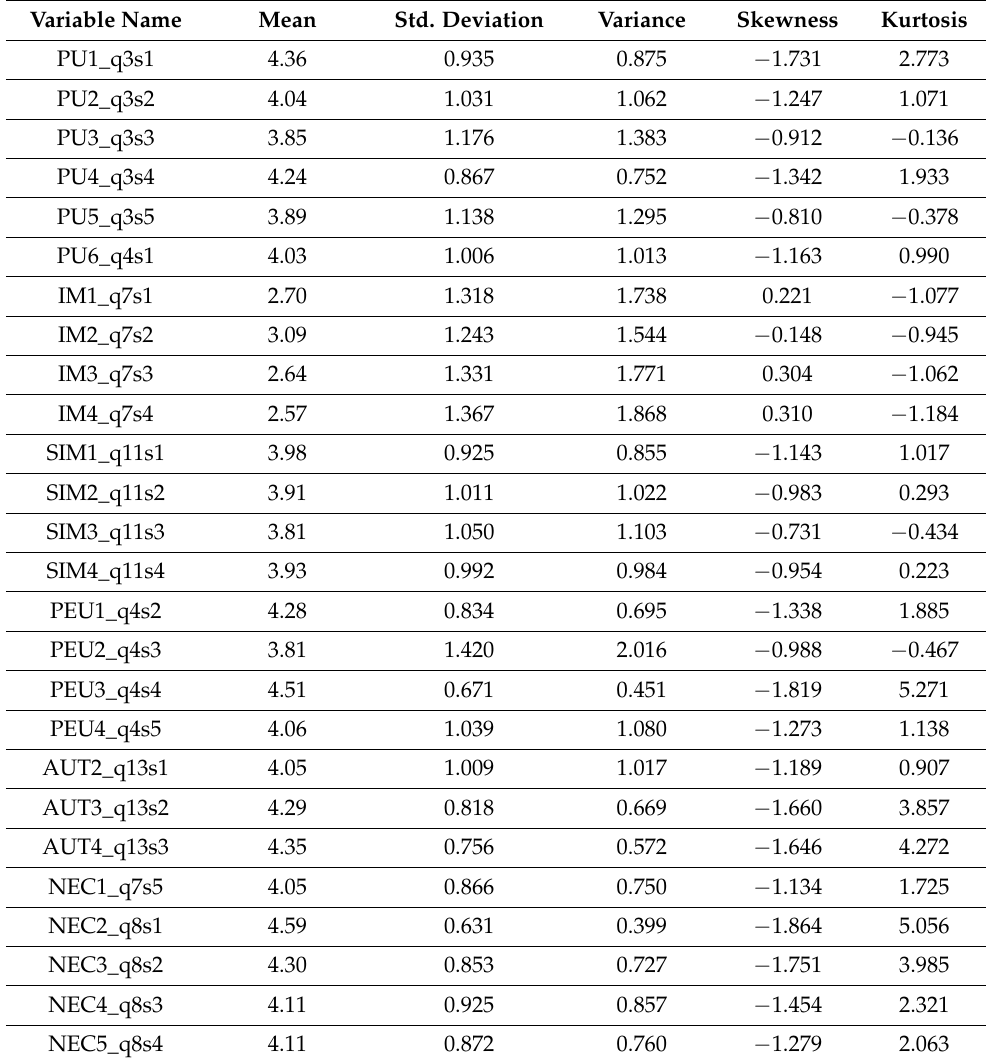
Table 2. Descriptive statistics of variable used in the model